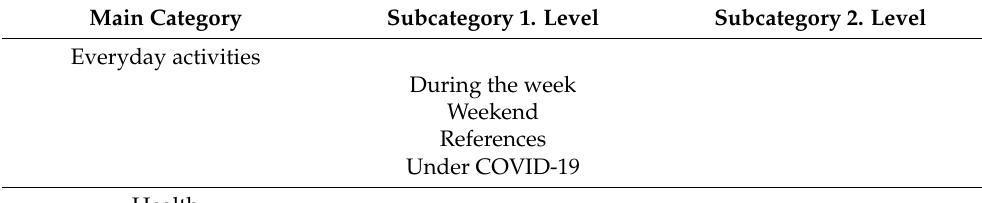
Table 2. Cross-national basis of the category system for the analysis of the interviews in